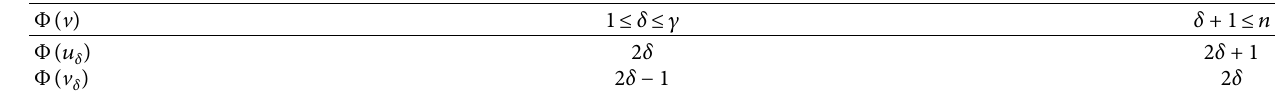
Table 29: Vertex labeling of Φ ( v ).